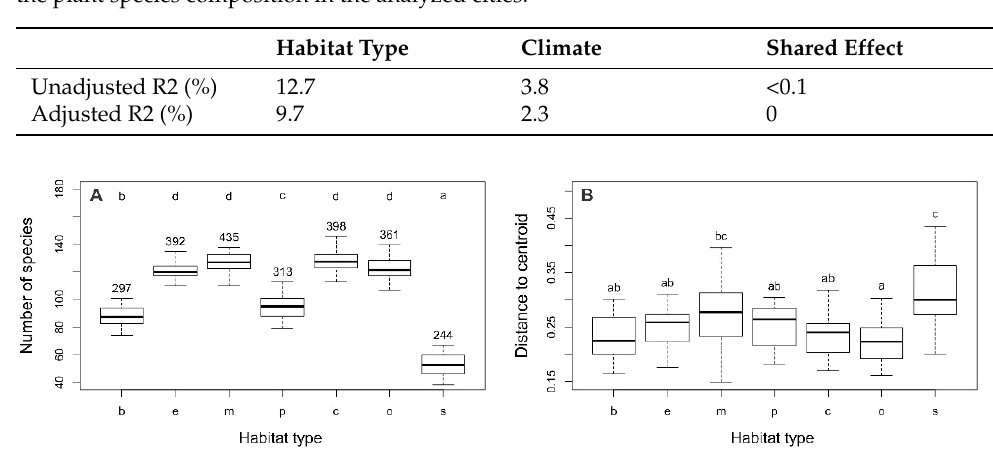
Table 3. Total explained variation, the influence of habitat type, climate, and their shared effect on the plant species composition in the analyzed cities.